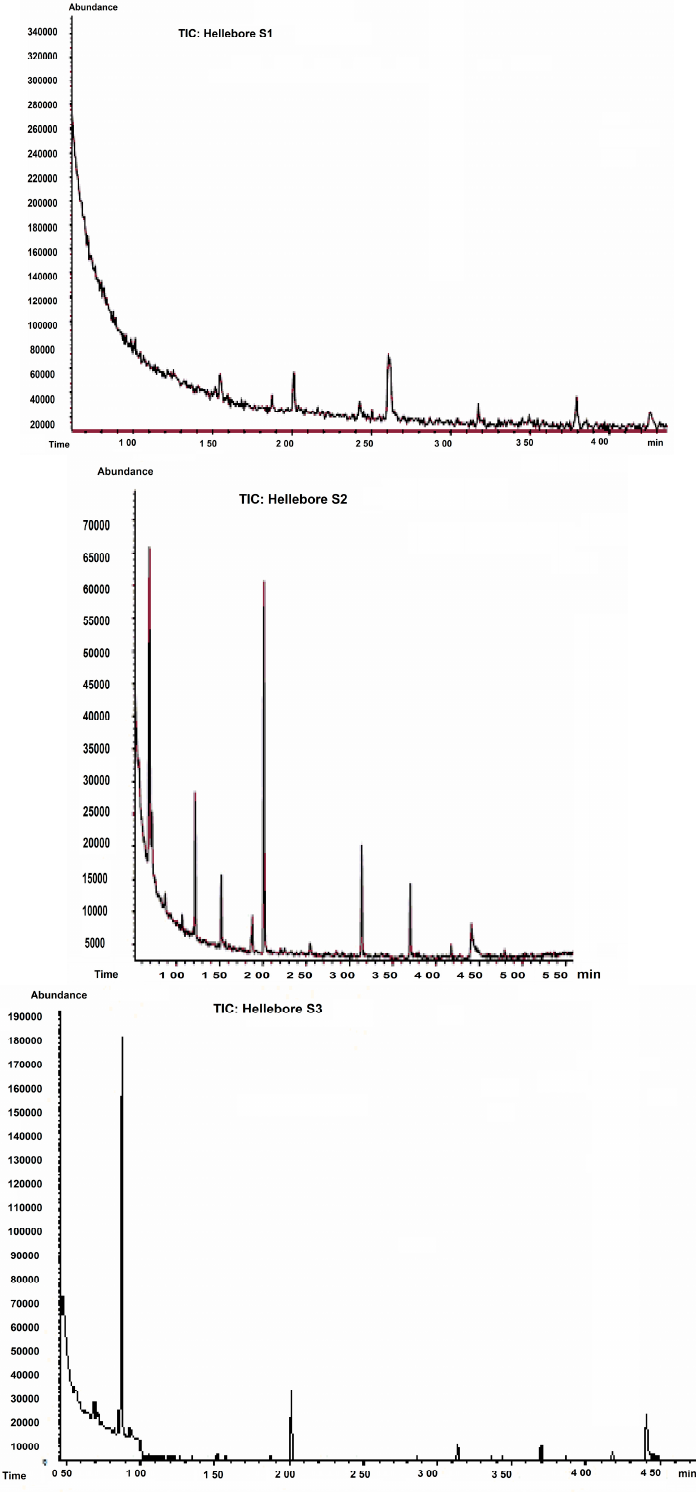
Figure 1. Cont Figure 1. Cont.